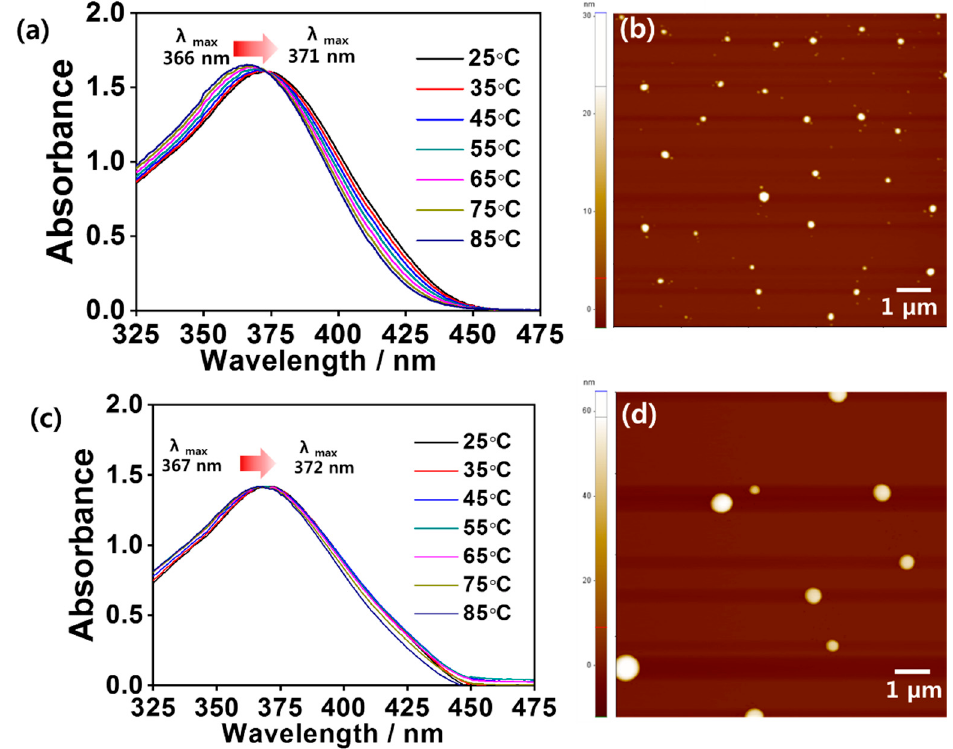
Figure 2. Temperature dependent UV–VIS spectra of probes ( a ) 1 (25 μ M) and ( c ) 2 (6.25 μ M) in DMSO/H 2 O (1/99, v / v %). AFM images of probes ( b ) 1 (100 μ M) and ( d ) 2 (100 μ M).